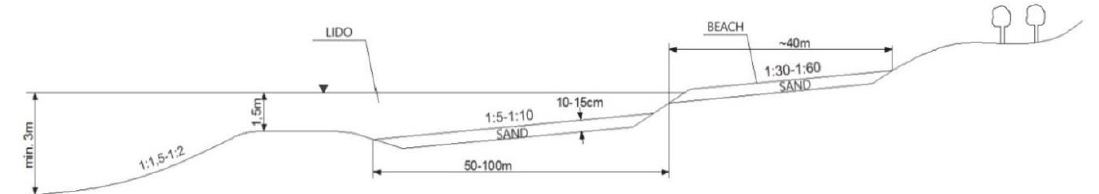
Figure 2. Profile of a lido in the excavation of rock raw material (own study based on Reference [23]).